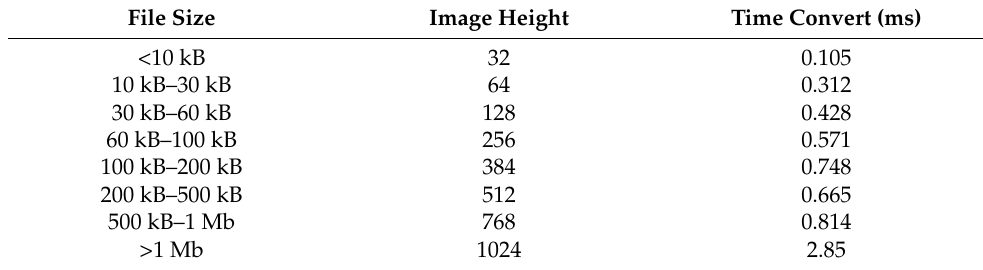
Table 1. Image height for different malware file